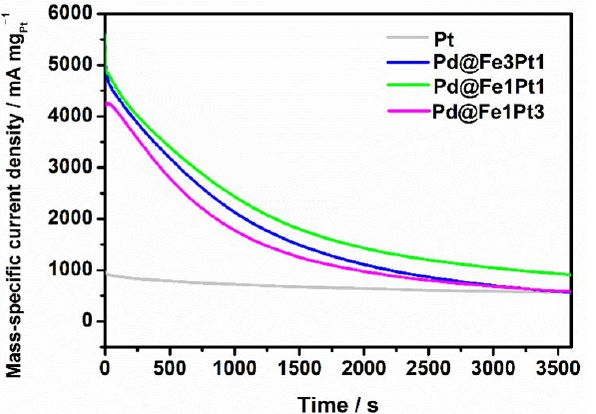
Figure 5. Current–time curves of Pd@FePt catalysts in 1 M CH 3 OH + 1 M KOH electrolyte. The current density was recorded at − 0.2 V for 3600 s and was based on the loading amount of